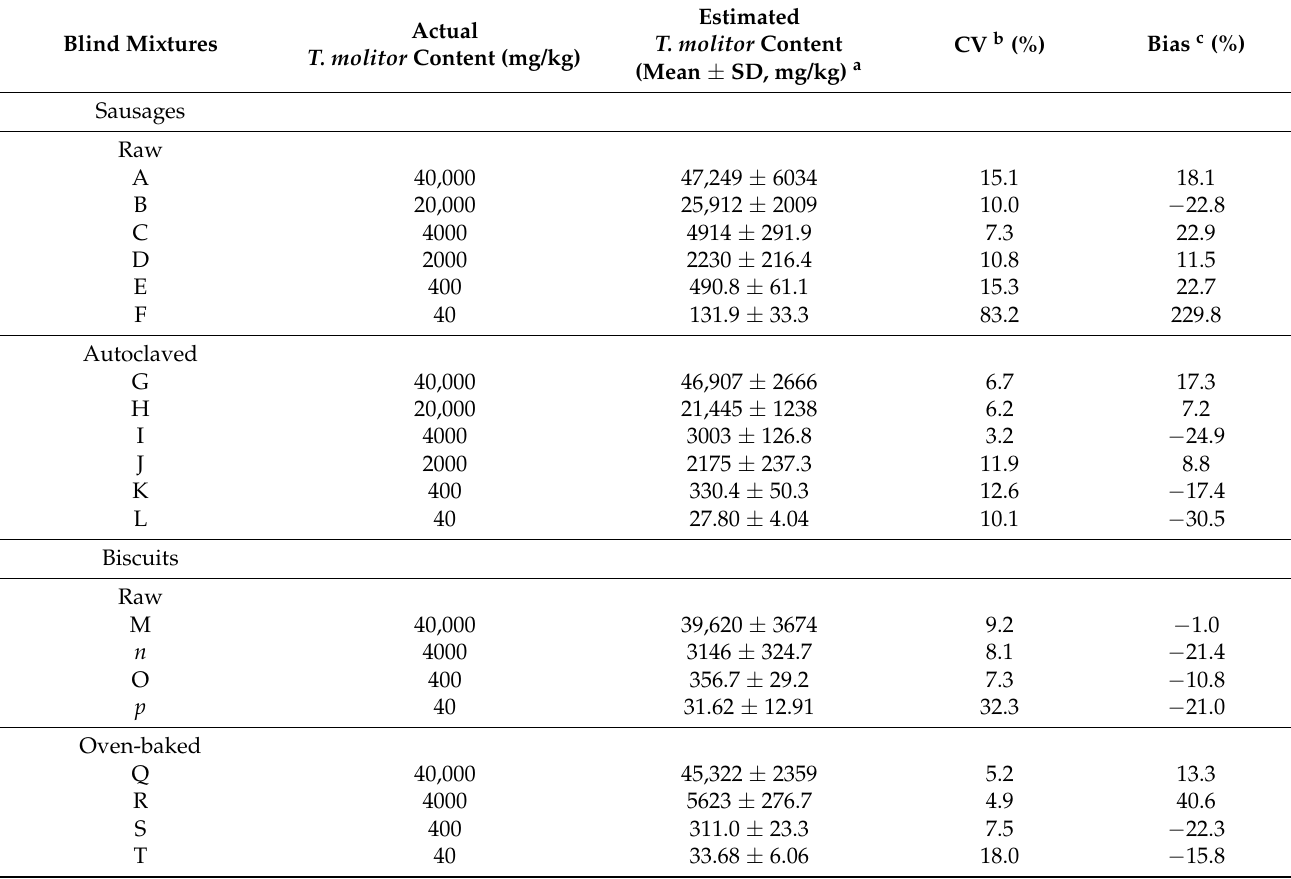
Table 3. Validation results of the real-time PCR system targeting the cytochrome b gene applied to blind mixtures of yellow mealworm in sausages and biscuits before and after thermal